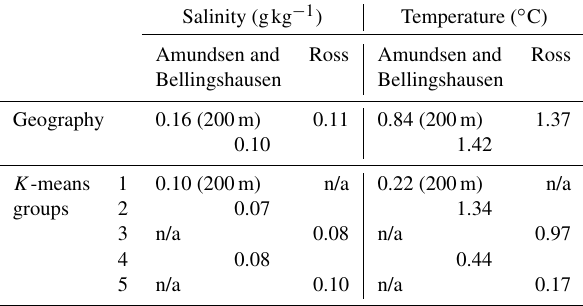
Table 3. The salinity and temperature standard deviation of WOA (at depth of 500m if not